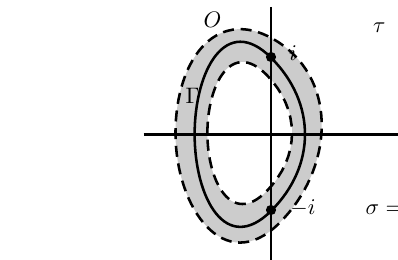
(cid:27)=(cid:28) . The curve in the middle 7! (cid:0)